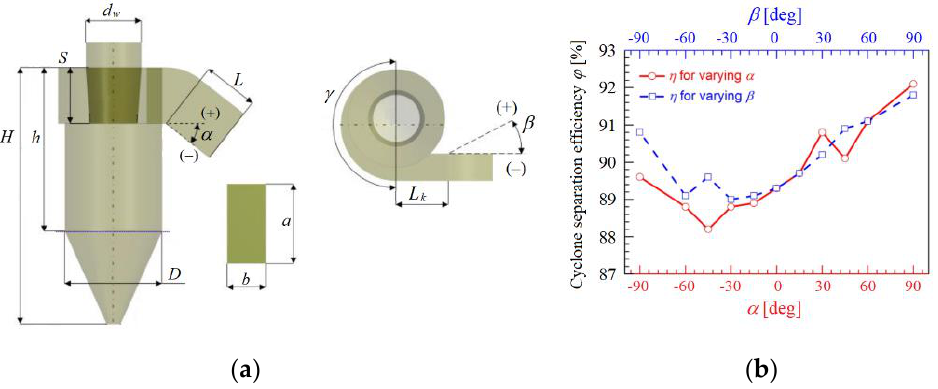
Figure 9. Effect of changing the angle of the cyclone inlet channel: ( a ) cyclone inlet channel angle in vertical plane α and horizontal plane β ; ( b ) effect of angles α and β on filtration efficiency. Figure made by the author based on data from the paper [69].